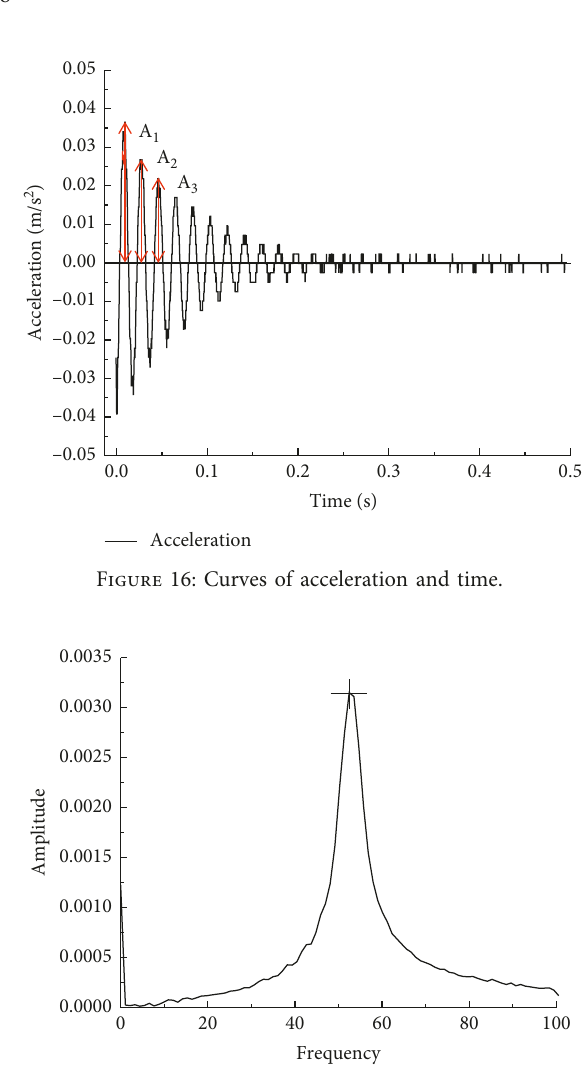
Figure 17: Curves of amplitude and